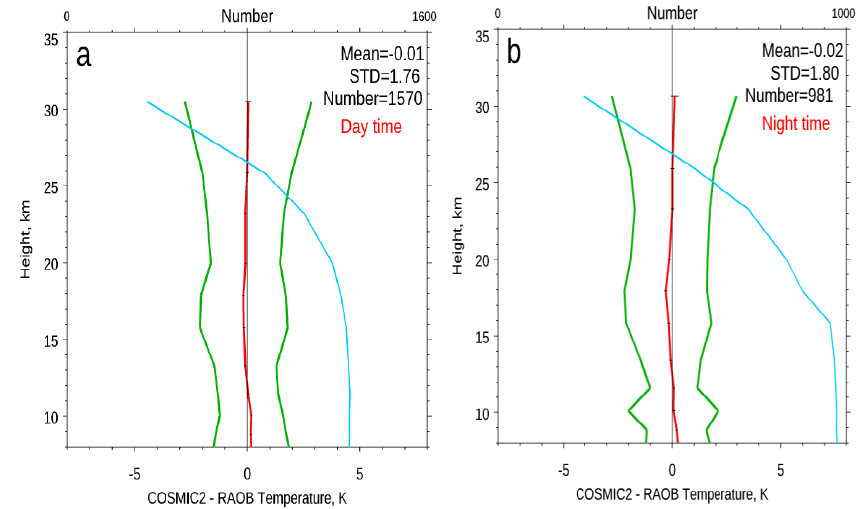
Figure 11. Similar to Figure 10 but for the COSMIC-2–RS41 pairs over ( a ) day time, and ( b ) night time. Moreover, these results are very compatible with those from COSMIC. Comparing COSMIC 10,000 COSMIC and Vaisala-RS92 pairs, ref. [46] confirmed that their mean bias in this height range was equal to − 0.01 K with a standard deviation of 2.09